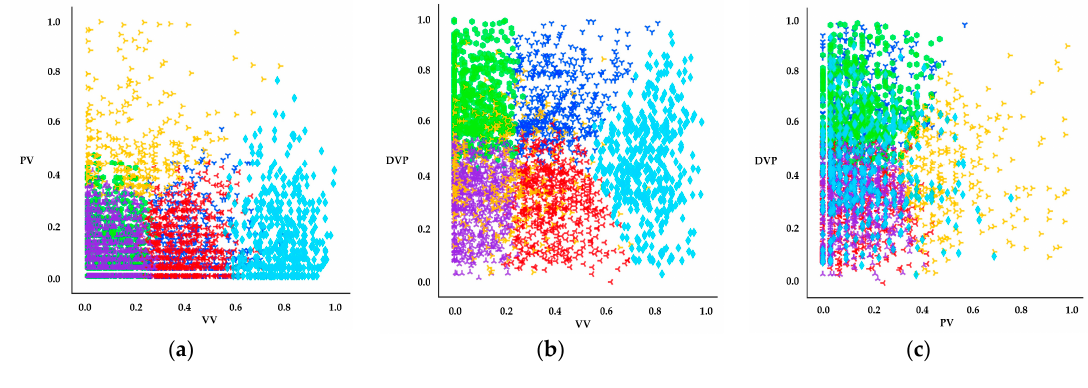
Figure 12. Cluster distributions of ( a ) VV–PV; ( b ) VV–DVP; and ( c ) PV–DVP.